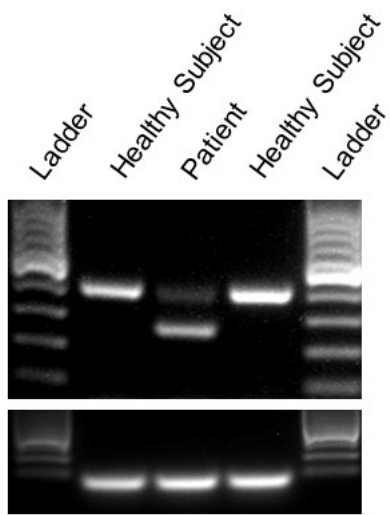
Figure 4. The c.1913 + 2T > G variant deletes exon 14. The RT-PCR analysis of cDNA from patient and control fibroblast using primers flanking exon 14 detected a 259 bp product in the patient. The PCR product obtained from healthy control individuals was 391 bp. A 100 bp DNA ladder was used as a marker to estimate the amplicon size.